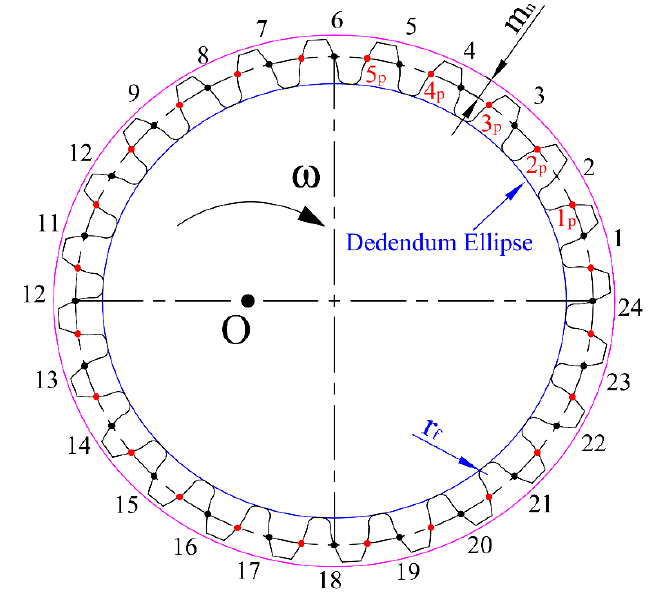
Figure 13. Resulting shape of the gear toothing.